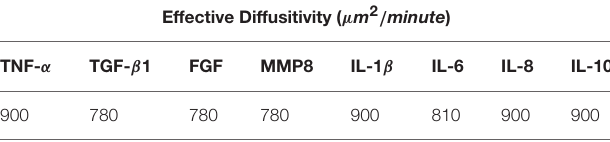
TABLE 4 | Effective diffusion coefficients used in 3D VF-ABM. Effective Diffusitivity ( µ m 2 / minute ) TNF-